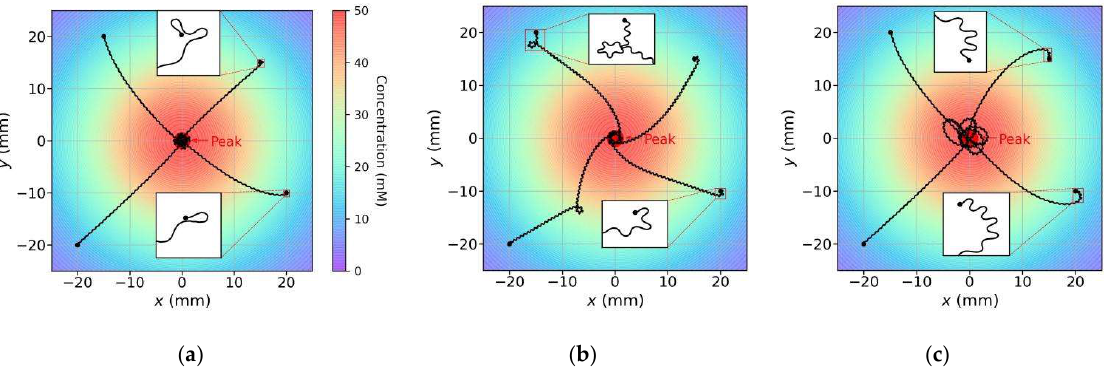
Figure 11. Search trajectories of three models in a given scenario: ( a ) the model exploiting parallel (klinokinesis and klinotaxis) strategies; ( b ) the klinokinesis-only model; and ( c ) the klinotaxis-only model. The four trajectories of each model have different initial positions and orientations, and the initial conditions were the same for all models. The color of each position in the scenario represents the concentration of that position (marked by the color bar in ( a )).